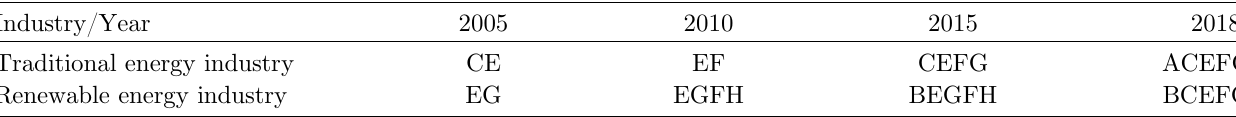
Table 4. Statistics of in fl uencing factors of spatial